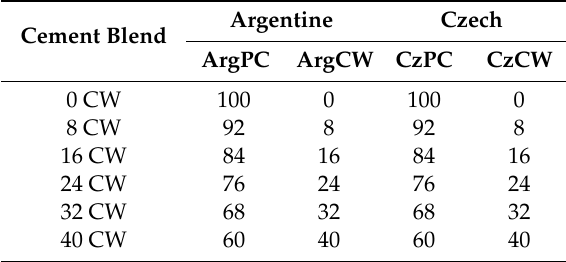
Table 2. Mix proportion of the analyzed pastes.